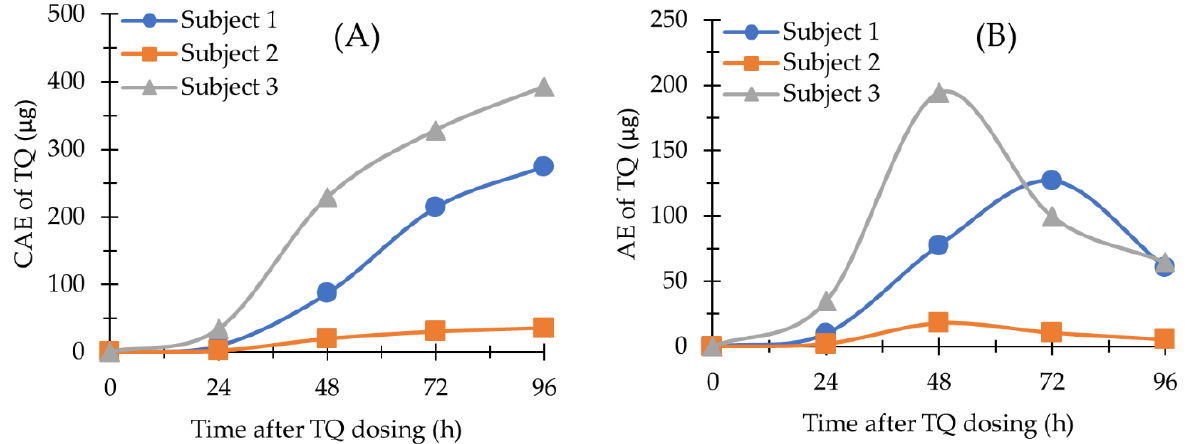
Figure 4. TQ in human urine ( n = 3). ( A ) The amount of TQ excreted (AE) versus time profile; ( B ) The cumulative amount of TQ excreted (CAE) versus time profile. Time was the endpoint of each 24 h urinary collection period.